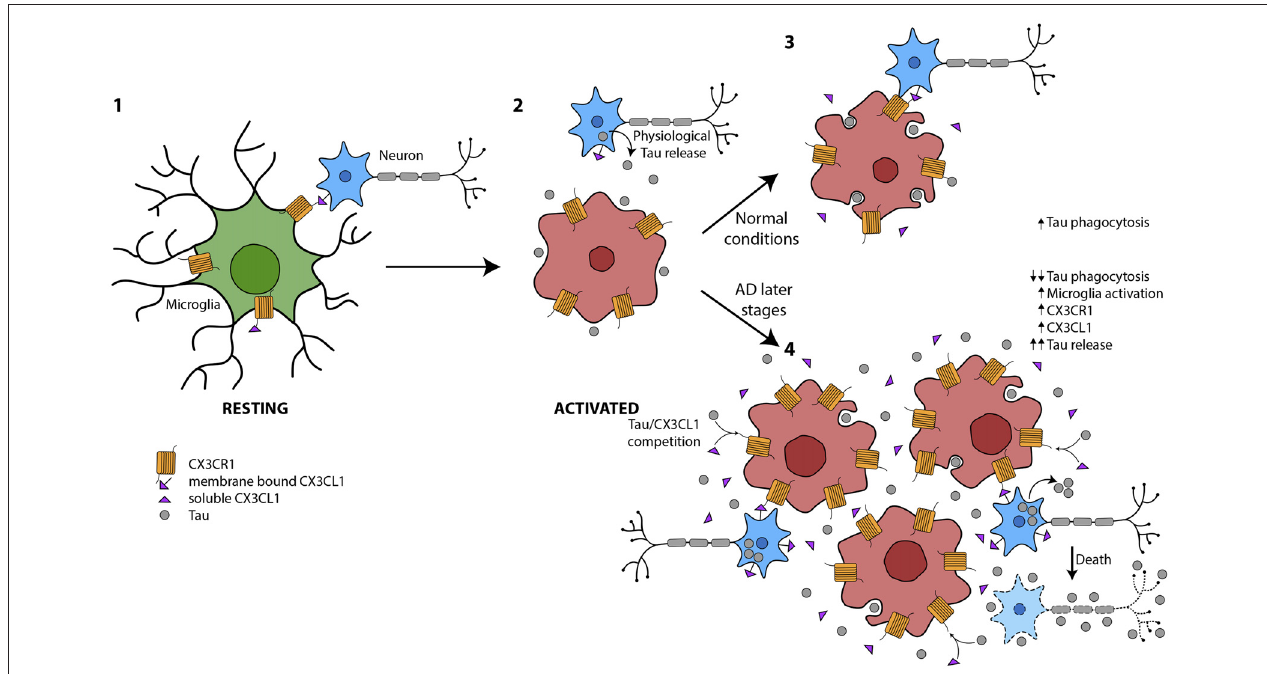
FIGURE 2 | Global picture of the contribution of microglia to Tau propagation. (1) Microglia in resting state where membrane-bound CX3CL1 and soluble isoforms are binding to the microglial CX3CR1. The CX3CL1/CX3CR1 axis is functioning properly. (2) Under several circumstances, such as the presence of Tau in the extracellular space, among others, microglia are activated. (3) Tau is phagocytosed by microglia under normal conditions. There is an equilibrium between microglial activation and phagocytosis in part mediated by CX3CL1/CX3CR1. (4) At later stages of Alzheimer’s disease (AD), there is an increase in Tau in the extracellular space, probably as a result of high neuron mortality. This Tau competes with CX3CL1 for binding to CX3CR1. Therefore, the phagocytosis of Tau is impaired and microglia are more activated and proliferate. The amount of CX3CL1 and CX3CR1 increase. However, the CX3CL1/CX3CR1 axis is